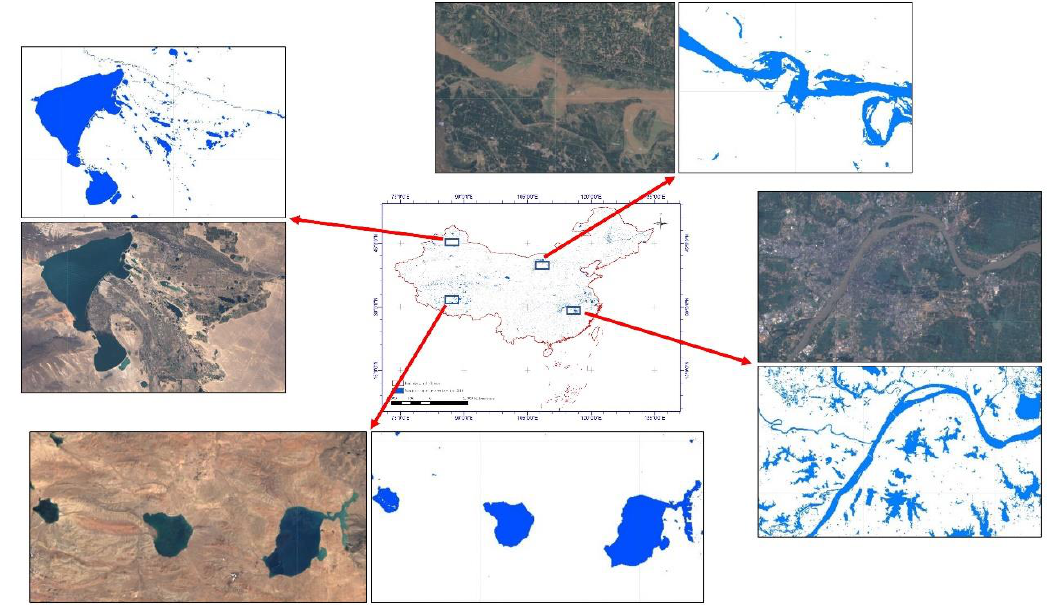
Figure 4. The visual comparison between extracted results and the original remote sensing images under different ground cover backgrounds.